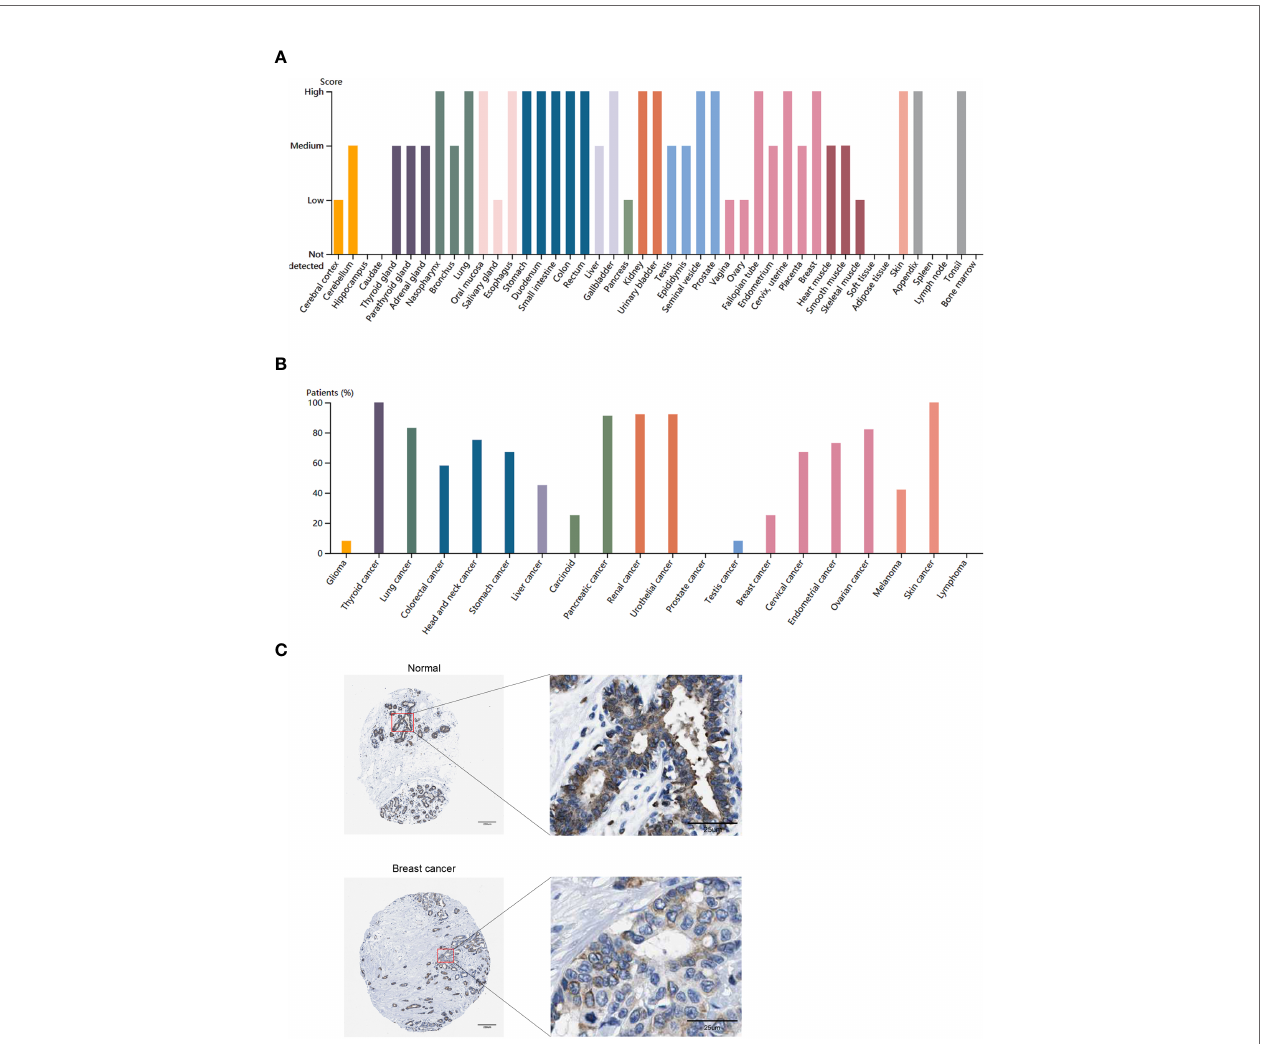
FIGURE 2 | ITGA3 translation level in different types of tumor tissues and normal tissues. (A) The protein level of ITGA3 in different types of normal tissues in HPA. (B) The protein level of ITGA3 in different types of tumor tissues in HPA. (C) Representative IHC images of ITGA3 in normal breast tissues and breast cancer tissues (The left scale bar, 200 m m; the right scale bar, 25 m